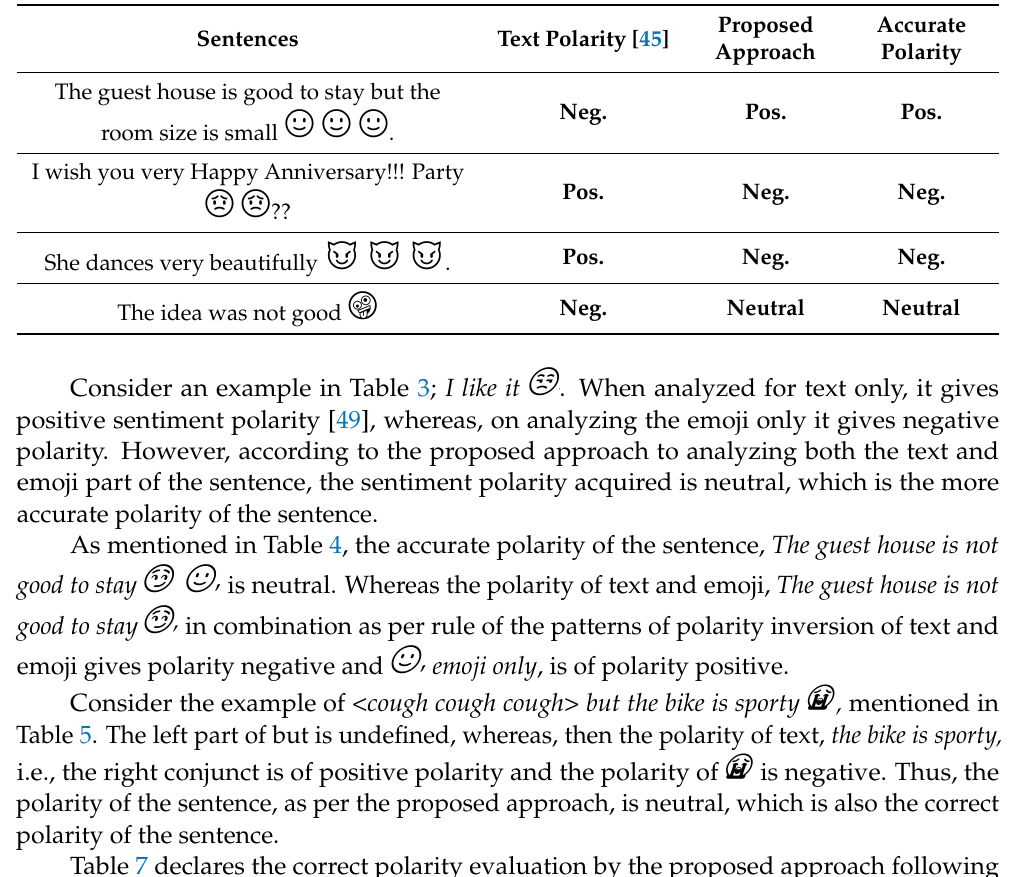
Table 7. Proposed work results for various ensemble of the linguistic features available in sentiment sentences.